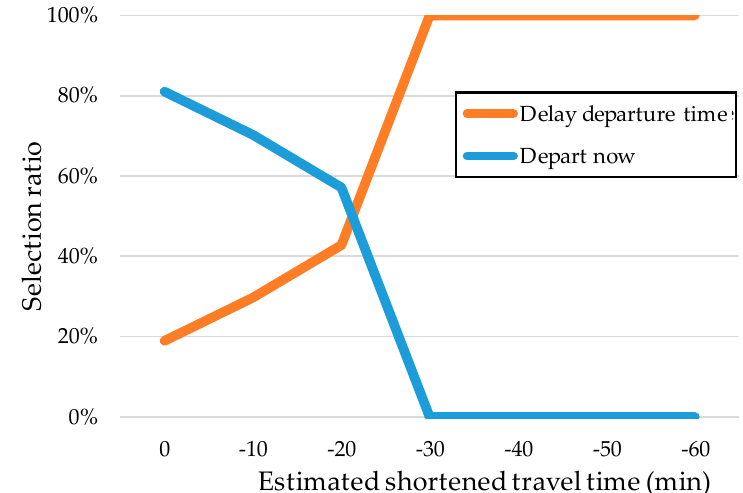
Figure 6. Selection ratio of “Depart now” and the other departure options based on estimated shortened travel time.